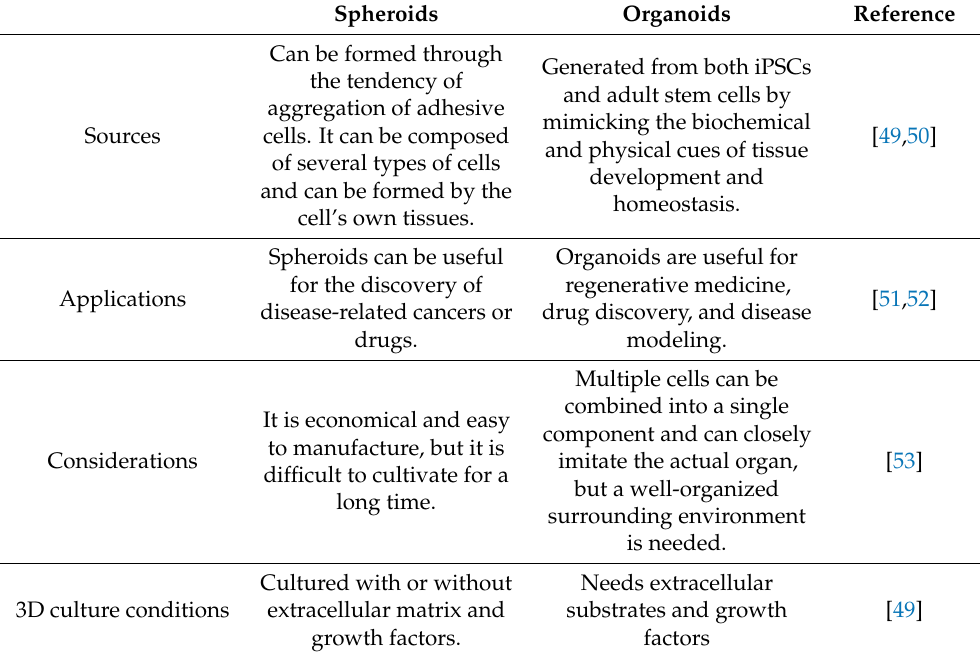
Table 2. Comparison of the basic characteristics of spheroids and